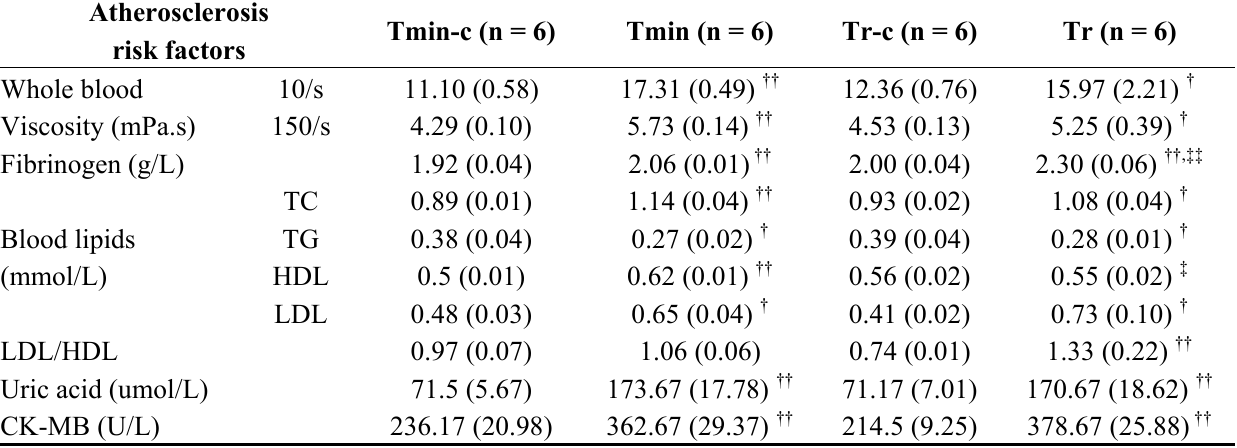
Table 2. CK-MB and atherosclerosis risk factors-WBV, FG, blood lipids and uric acid in different